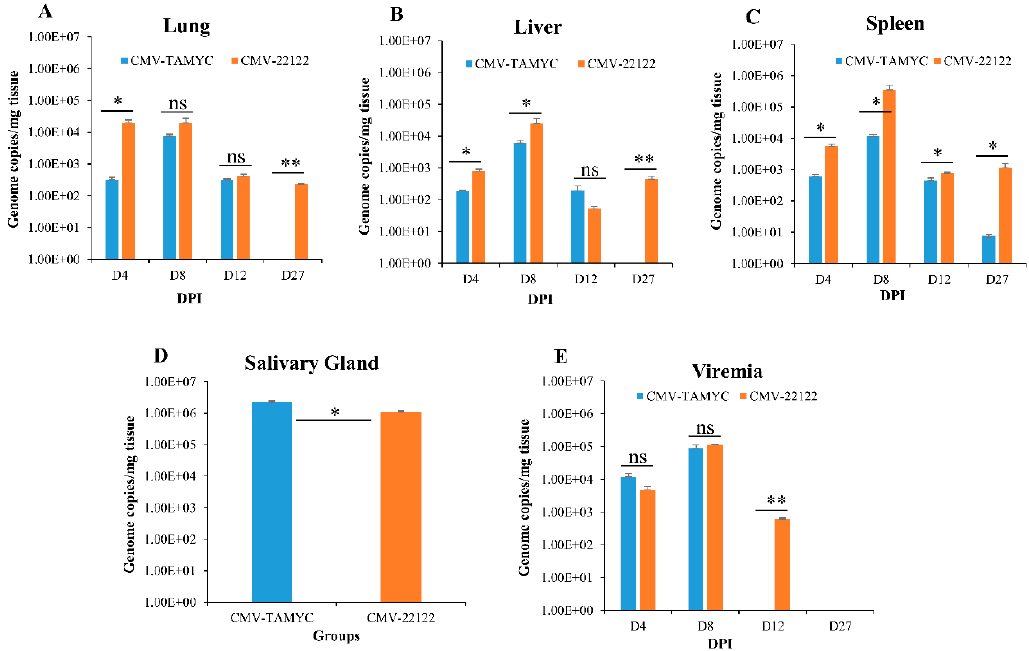
Figure 3. Dissemination of di ff erent GPCMV strains to target organs. Seronegative animals ( n = 12 / group) were inoculated with TAMYC (blue) or 22122 wt GPCMV (orange). At 4, 8, 12 and 27 days post infection (dpi), 3 animals from each group were evaluated for viral load in target organs: ( A ) lung; ( B ) liver; ( C ) spleen, by real-time PCR of DNA extracted from tissues. Viral load plotted as viral genome copies / mg tissue. Salivary gland tissue ( D ) was only evaluated at 27 dpi. Viremia detected at 4, 8, 12 and 27 dpi was plotted as genome copies / mL blood ( E ). Unpaired t test at 95% confidence interval * p < 0.05; ** below level of detection; ns = not significant.